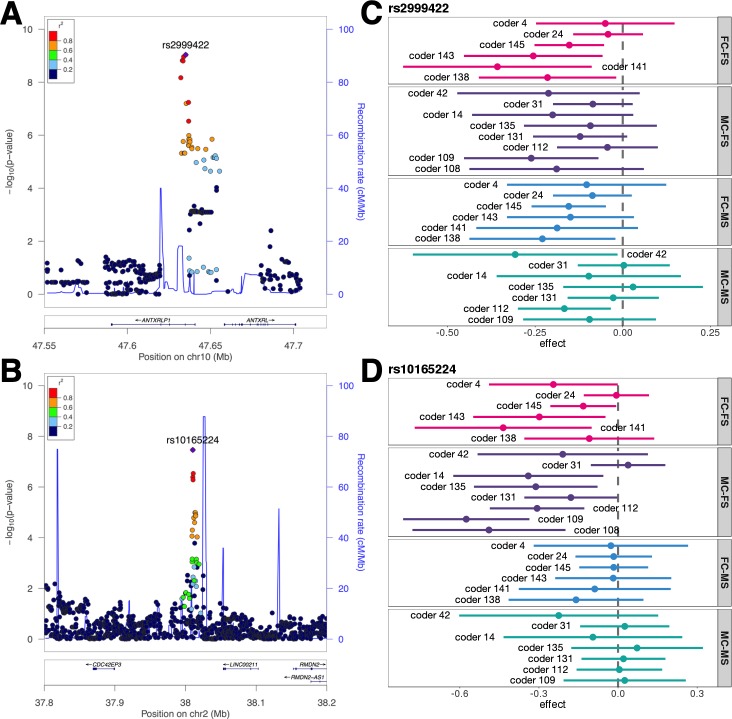
Associations at two genome-wide significant loci.(A) Association with FC-AS at 10q11.22. (B) Association with MC-FS at 2p22.2. (C-D) Associations with each coder’s attractiveness ratings at two genome-wide significant loci. Each interval shows the association with attractiveness score given by one coder. Error bars denote 95% confidence intervals of effect estimates. To maintain sufficient sample size, only coders who rated more than 500 male samples were included in MS studies and coders who rated more than 500 female samples were included in FS studies.